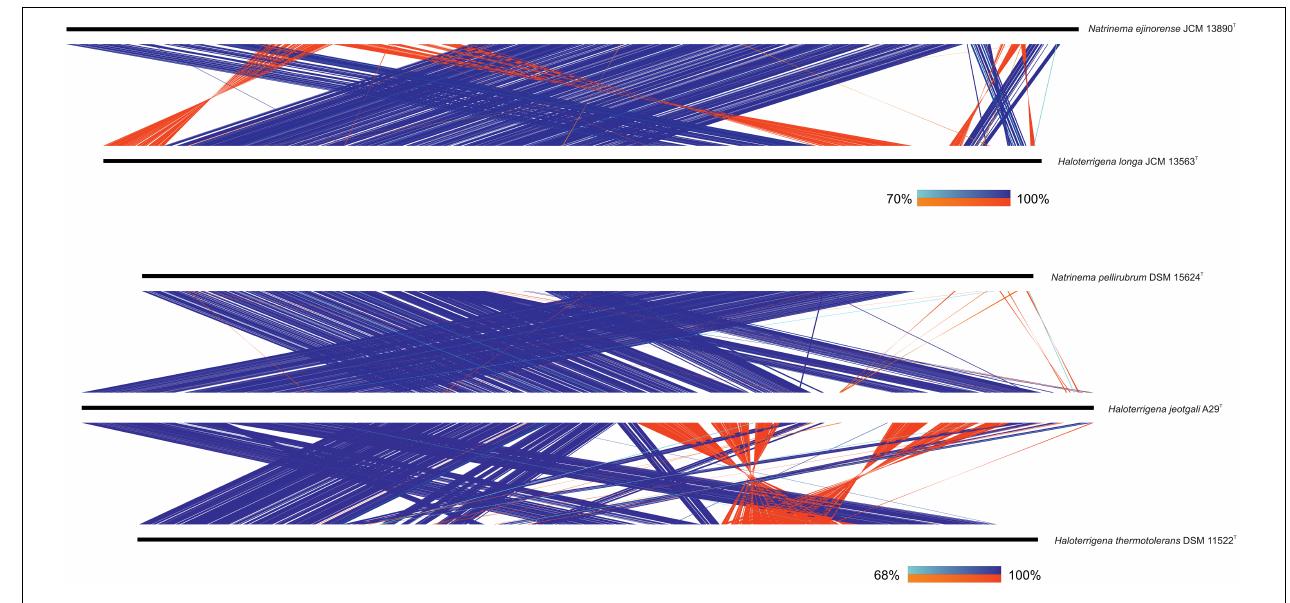
FIGURE 5 | Synteny plot between the genomes of Natrinema ejinorense and Haloterrigena longa (above) and among the genomes of Natrinema pellirubrum , Haloterrigena jeotgali, and Haloterrigena thermotolerans (below) . Only matches with ≥ 500 bp alignment length and ≥ 90% identity are